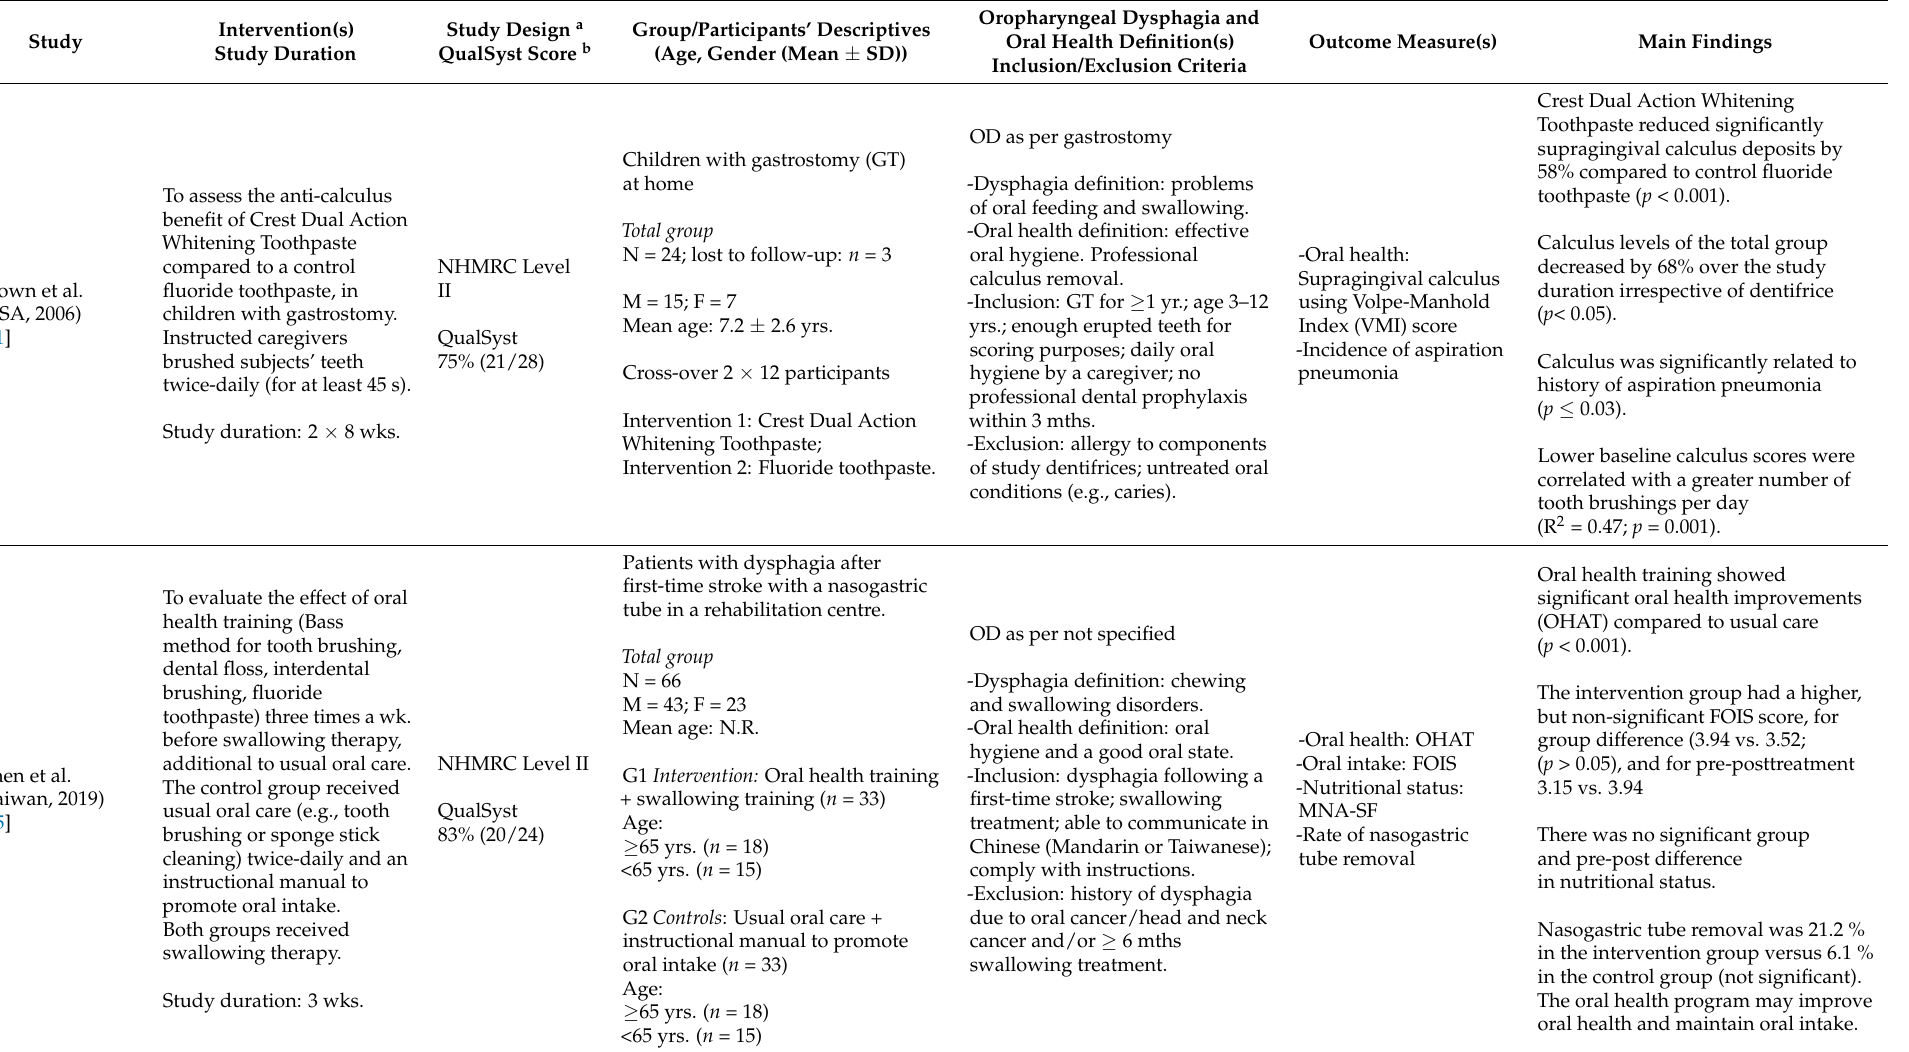
Table 2. Study characteristics of the eight oral health interventions in oropharyngeal